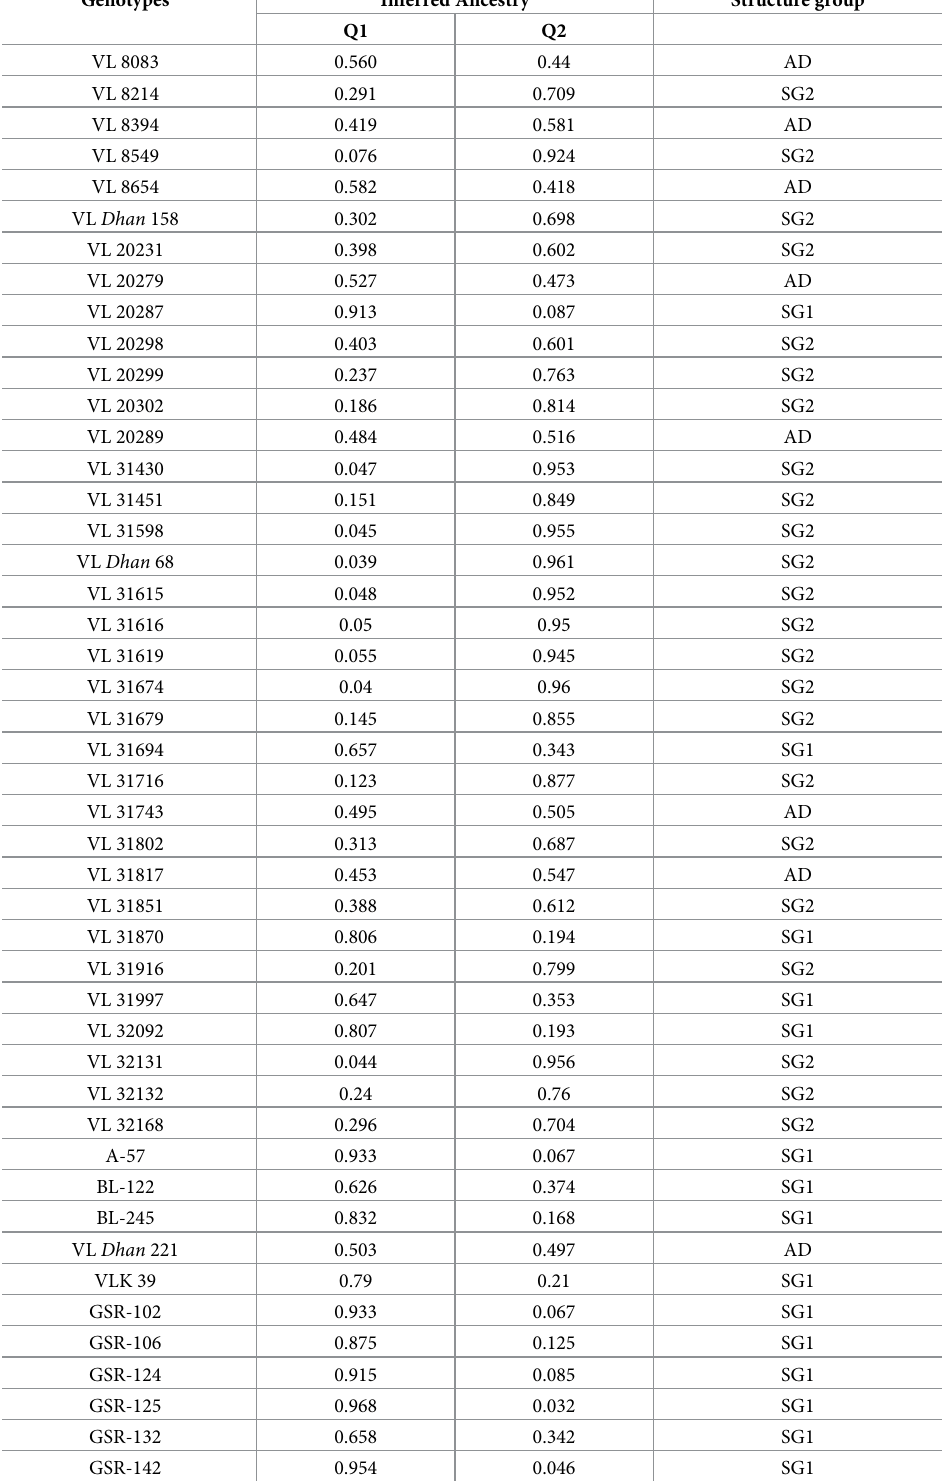
Table 6. Population structure group of 52 genotypes based on inferred ancestry